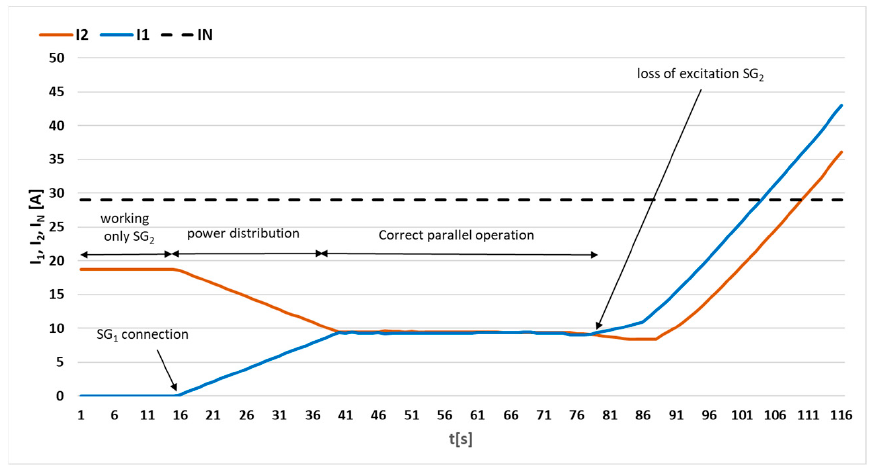
Figure 19. Time waveforms of currents I 1 and I 2 obtained during the laboratory tests.